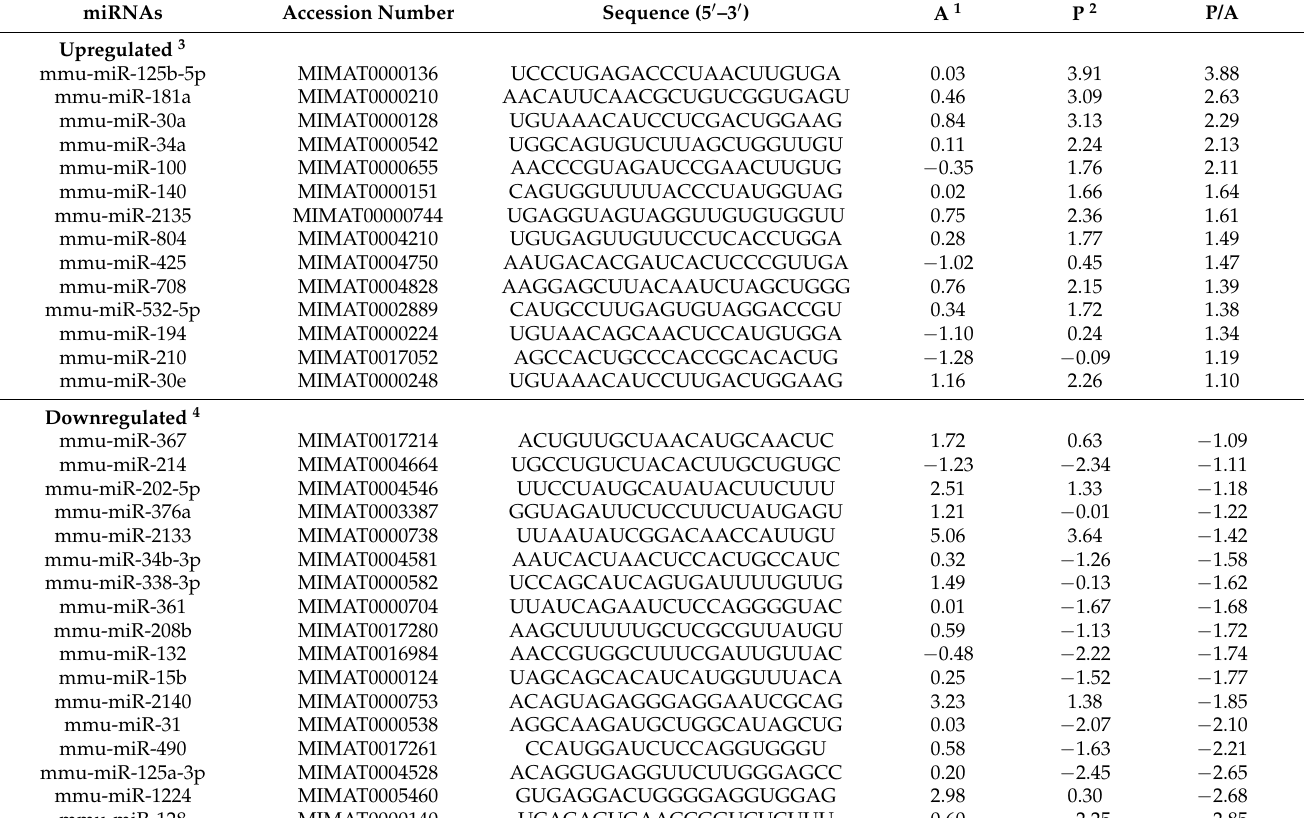
Table 1. The list of up- and down-regulated expression of miRNAs detected from the mock, JEV acutely infected, and JEV persistently infected BHK21 cells.